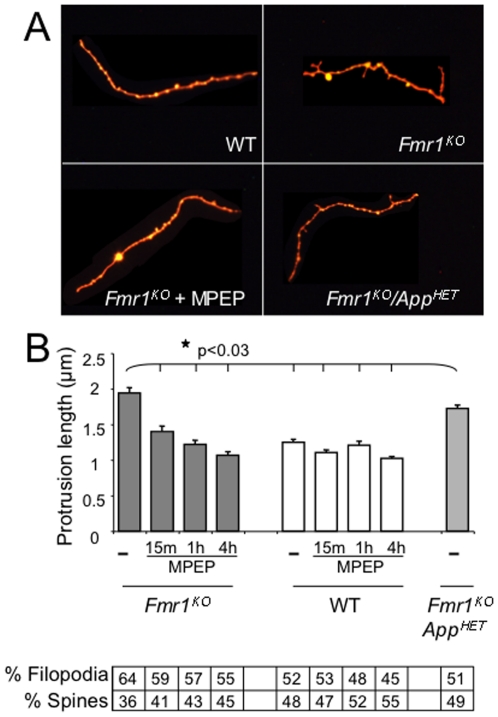
Dendritic spine morphology is partially rescued in Fmr1KO/AppHET or MPEP treated Fmr1KO mice.(A) Representative fluorescent images of primary cultured neurons prepared from WT (upper left), Fmr1KO (upper right and lower left) and Fmr1KO/AppHET (lower right) embryos stained with DiI and visualized by fluorescent microscopy (100× objective). The arrows denote dendritic spines. (B) The lengths of dendritic protrusions were quantitated with StereoInvestigator software and plotted against mouse strain/treatment. The percentage of filopodia versus spines for each condition is given below the histogram. Statistics: one-way ANOVA comparison of the three genotypes (untreated) p<0.0001, F = 27.18. All genotypes are statistically different from each other by Student T-Test and Bonferroni's multiple comparison tests. Two-way ANOVA comparison of WT versus Fmr1KO ± MPEP: p<0.0001, F = 12.89 (interaction), F = 35.01 (genotype) and F = 27.62 (MPEP). The untreated and 15 min MPEP treated WT spines are statistically different from the corresponding Fmr1KO spines by the Bonferroni multiple comparison test (p<0.5). Stars (★) denote statistically different spine lengths by Student T-test analyses (p<0.5). Error bars indicate SEM [Fmr1KO: untreated (n = 746 spines), 15 min MPEP (n = 263), 1 hr MPEP (n = 300), 4 hr MPEP (n = 293); WT: untreated (n = 994), 15 min MPEP (n = 535), 1 hr MPEP (n = 373), 4 hr MPEP (n = 1221); Fmr1KO/AppHET (n = 2469)].